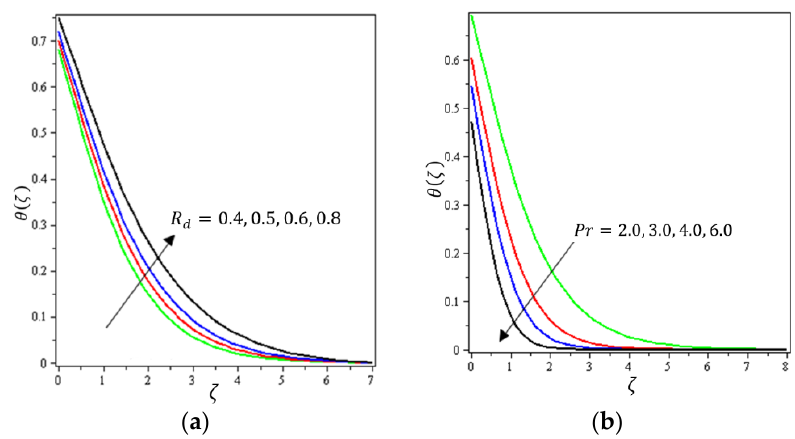
Figure 7. Influence of ( a ) radiative flow 𝑅 (cid:3031) and ( b ) Prandtl number 𝑃𝑟 on 𝜃(𝜁) .